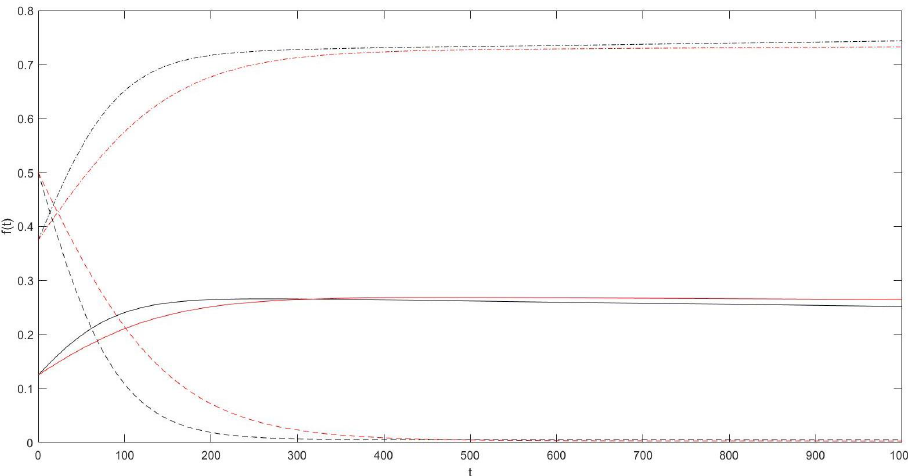
Figure 4. In black the solution for B i